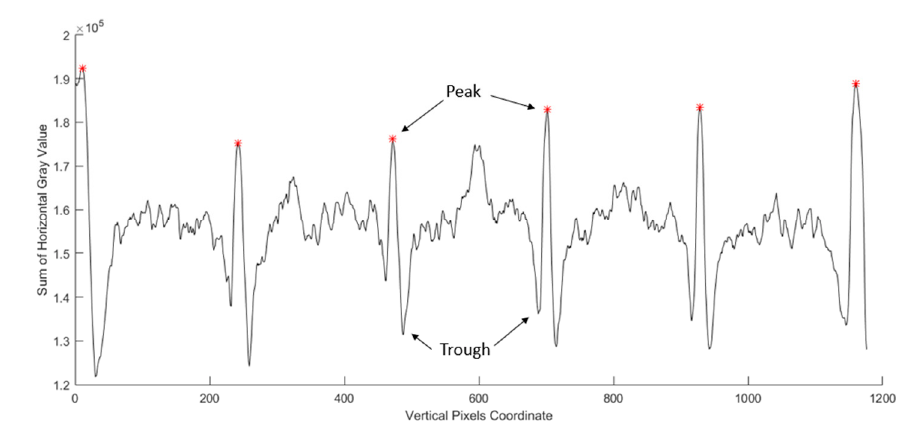
Figure 5. Grayscale horizontal distribution curve of the 50 cells plug tray.